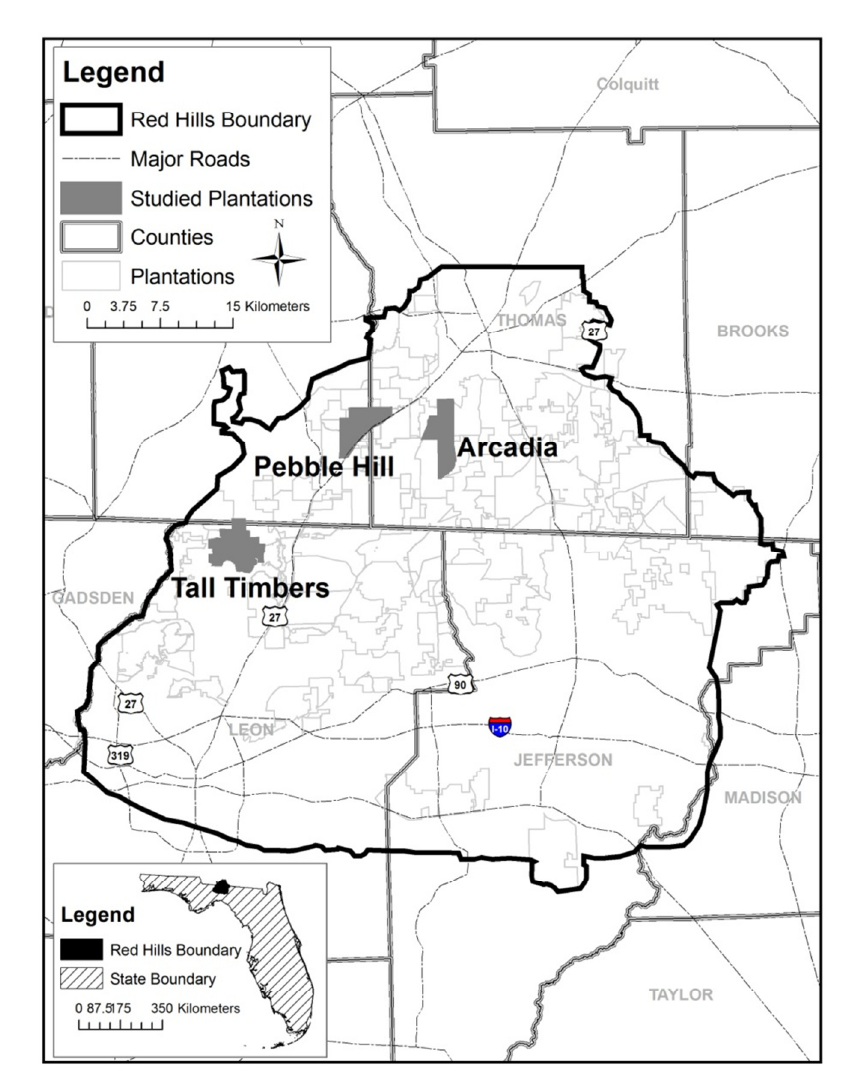
Figure 1. Location of Tall Timbers Research Station (TTRS), Pebble Hill, and Arcadia plantations within the Red Hills